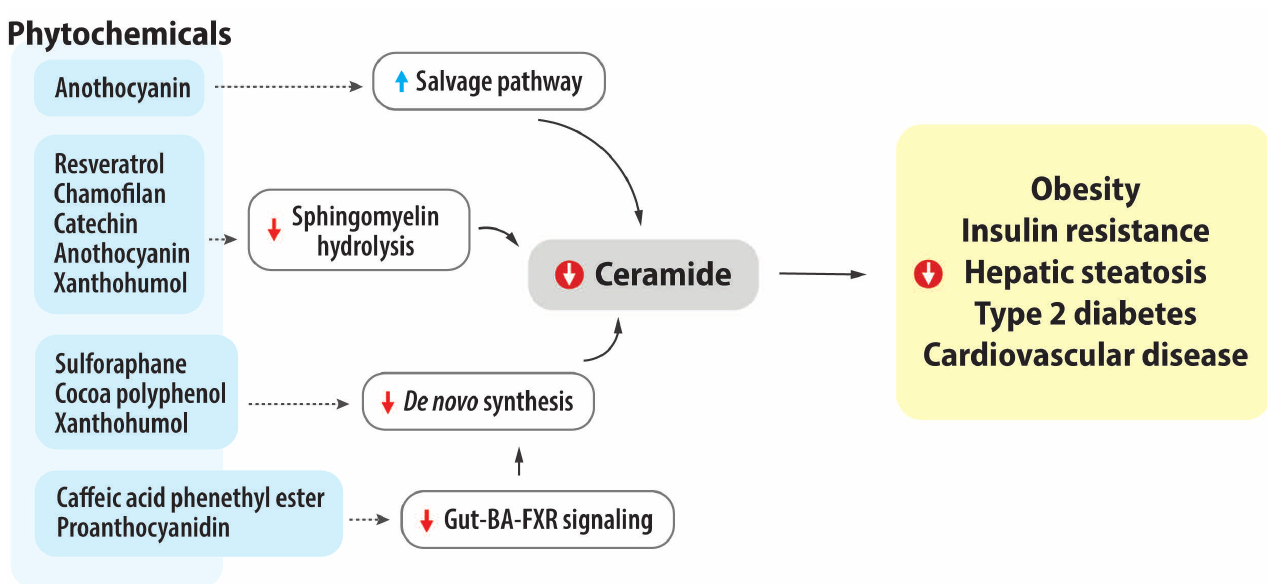
Figure 2. The impact of phytochemicals on ceramide metabolism and physiological